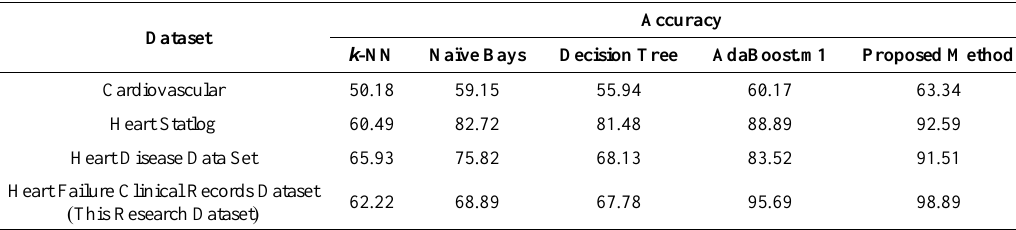
Table 6. Tests with other cardiac datasets